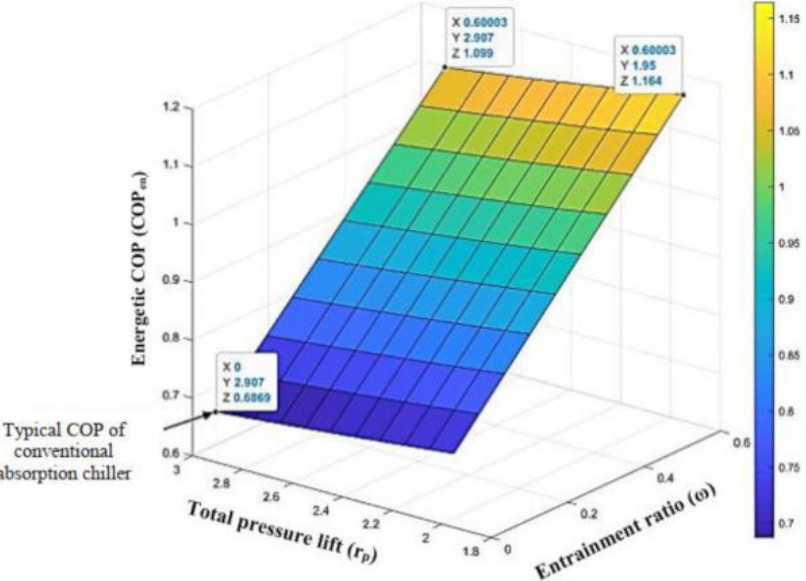
Figure 19. Variation of the energetic COP (COP en ) with entrainment ratio ( ω ) and total pressure lift (r p )